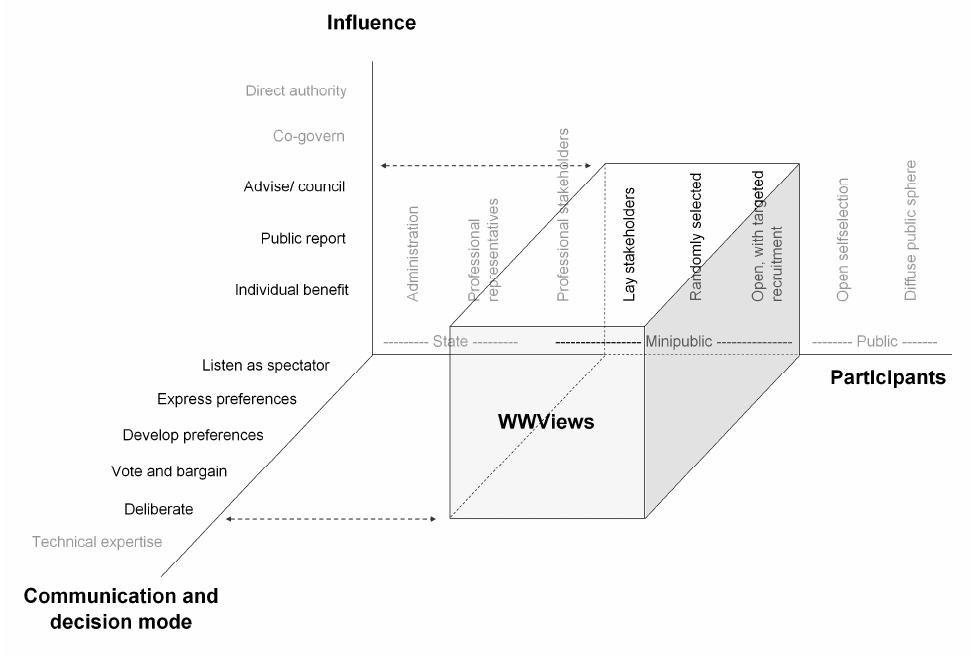
Fig. 2: WWViews becomes visible as an advisory process taking